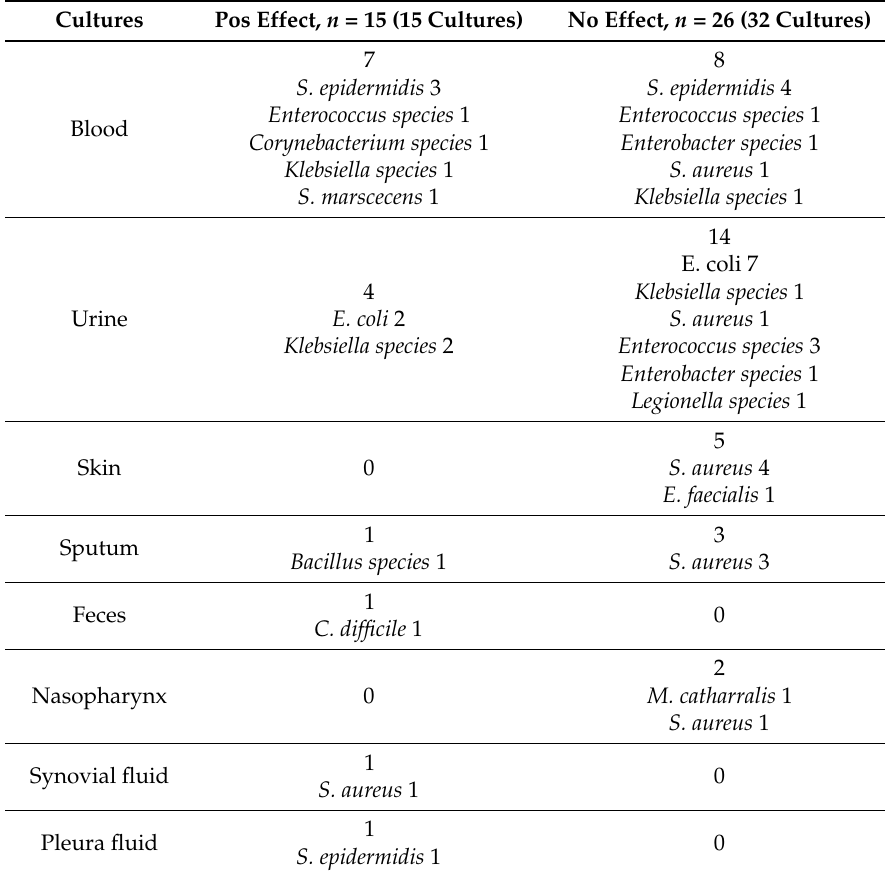
Table 2. Pathogens in the positive cultures ( n = 41 patients).